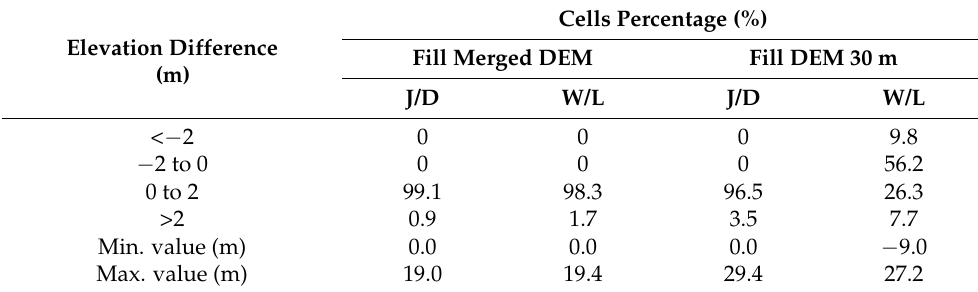
Table 3. Percentage of elevation variation between the pre-treated DEMs and the fill DEMs.